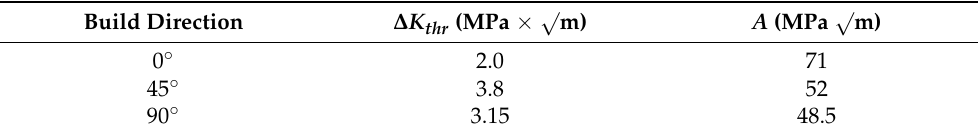
Figure 3. Measured and computed crack growth histories for the SLM Ti-6Al-4V tests reported in [20]. Table 4. Values used in Figure 3.